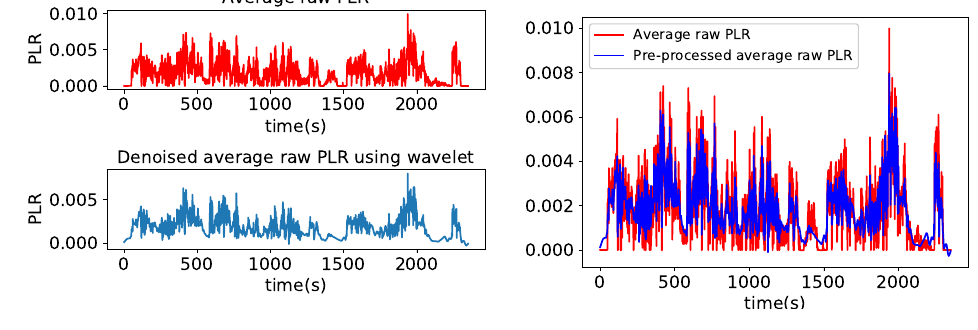
Figure 5. The wavelet domain de-noising process of average raw PLR.